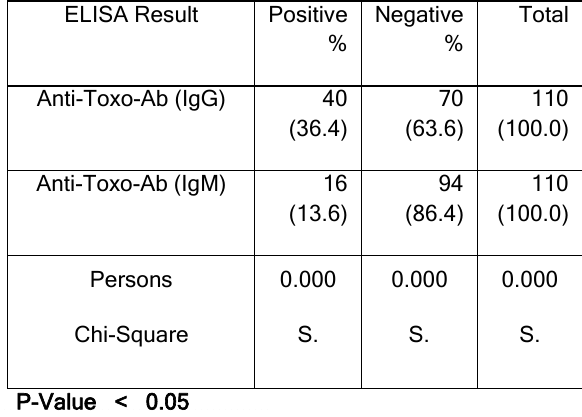
Table (1): Distrubution according to the seropositivity rates by ELISA (IgG, IgM) of pregnant women: